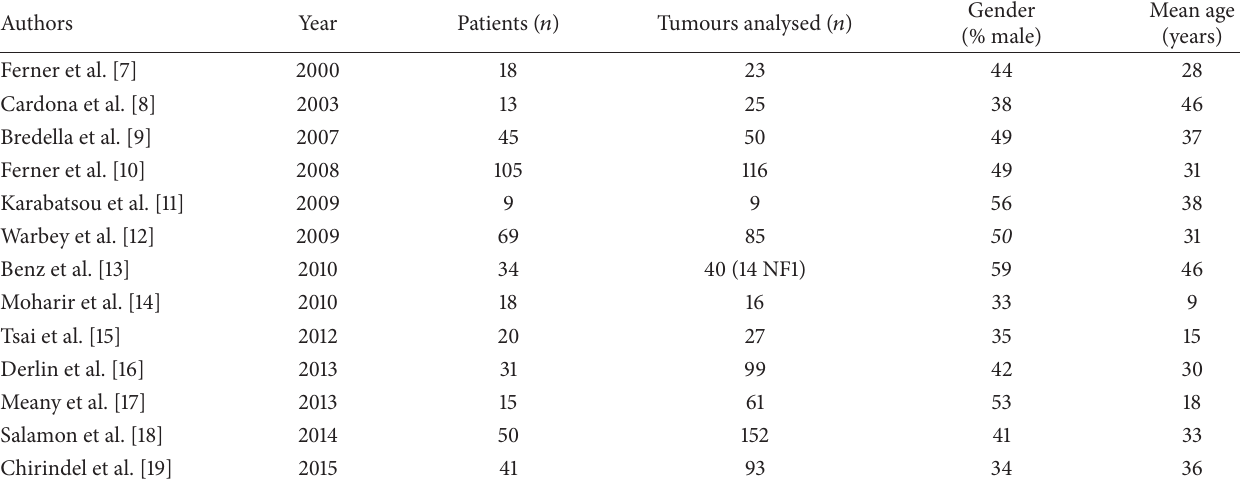
Figure 1: Study selection and search strategy. Table 1: Basic demographic characteristics of included